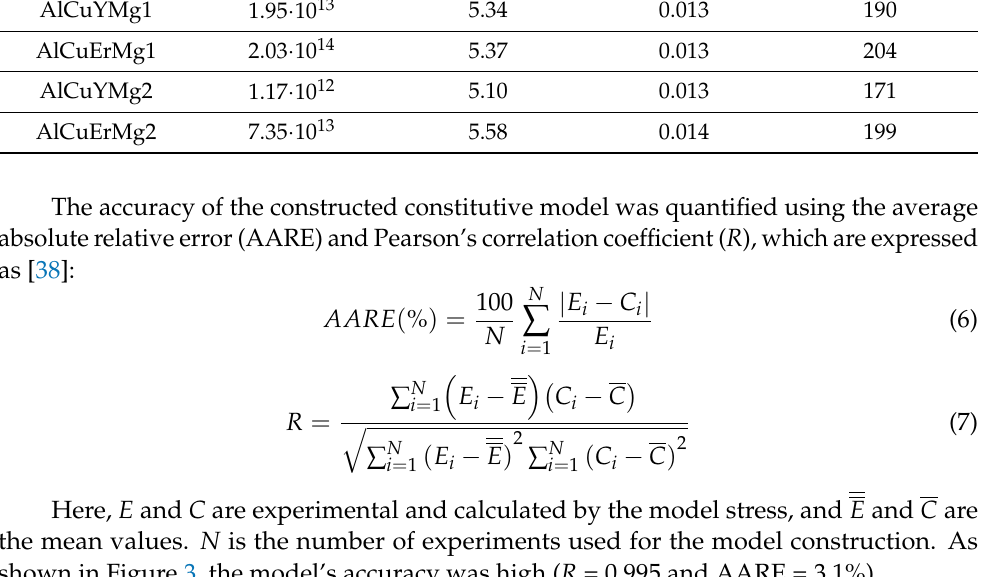
Table 3. The values of the Zener–Hollomon parameter-based models.